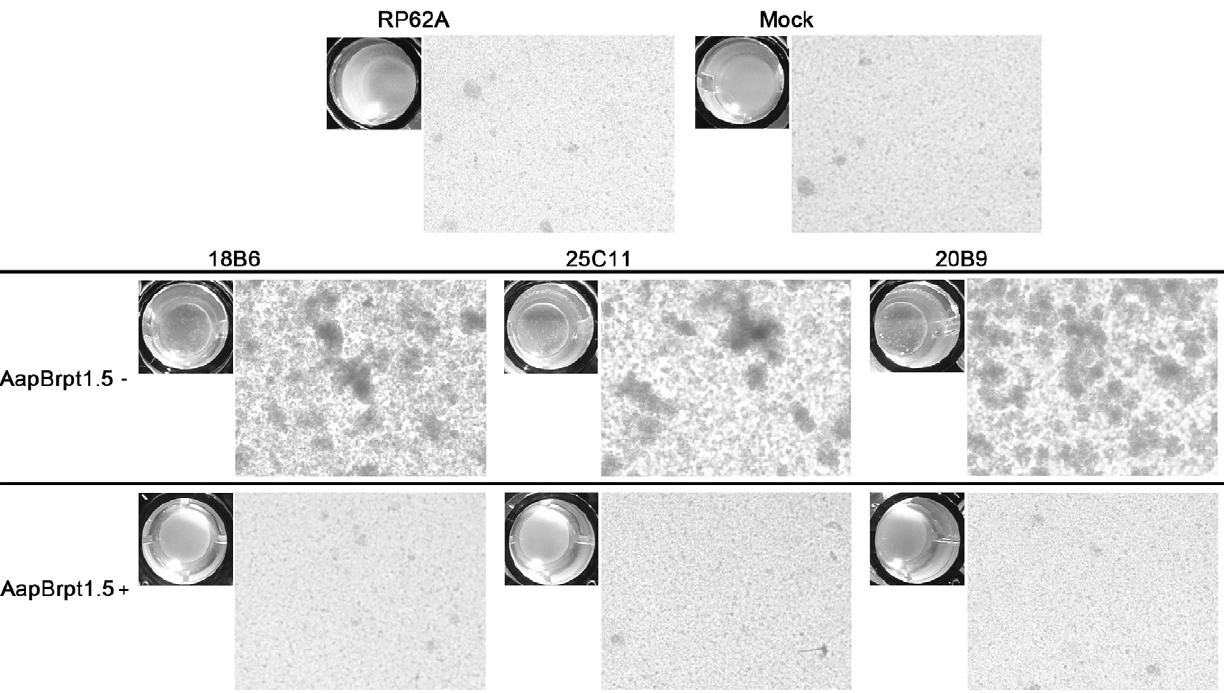
Figure 4. Cell aggregation mediated by the MAbs. S. epidermidis RP62A was statically cultured in TSB medium containing each MAb (10 m g/mL, 0.07 m M) alone or both MAb (10 m g/mL, 0.07 m M) and AapBrpt1.5 (untagged, 3.2 m g/mL, 0.14 m M). The photomicrographs were obtained by a